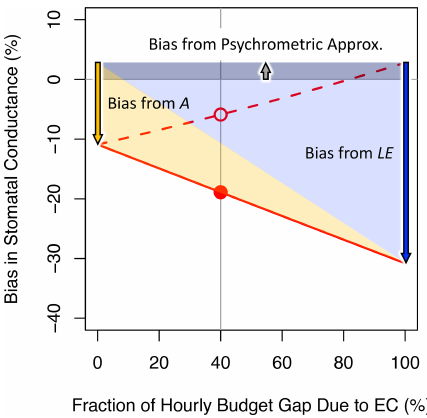
Figure 2. Inverted Penman–Monteith results from Fig. 1a, anno- tated to indicate the various sources of